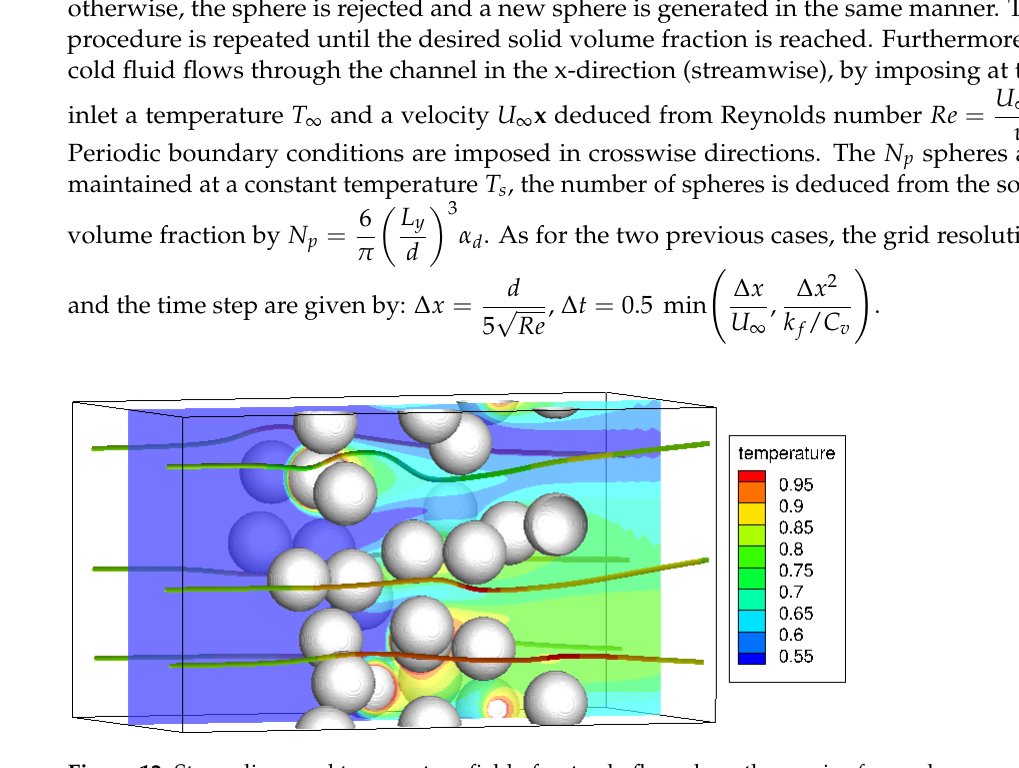
Figure 12. Streamlines and temperature field of a steady flow along the x-axis of a random array of spheres at Re = 100 and α d =